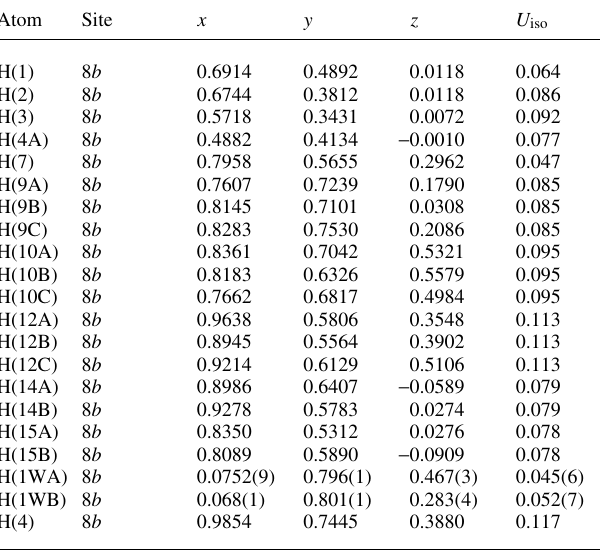
Table 2. Atomic coordinates and displacement parameters (in Å 2 )